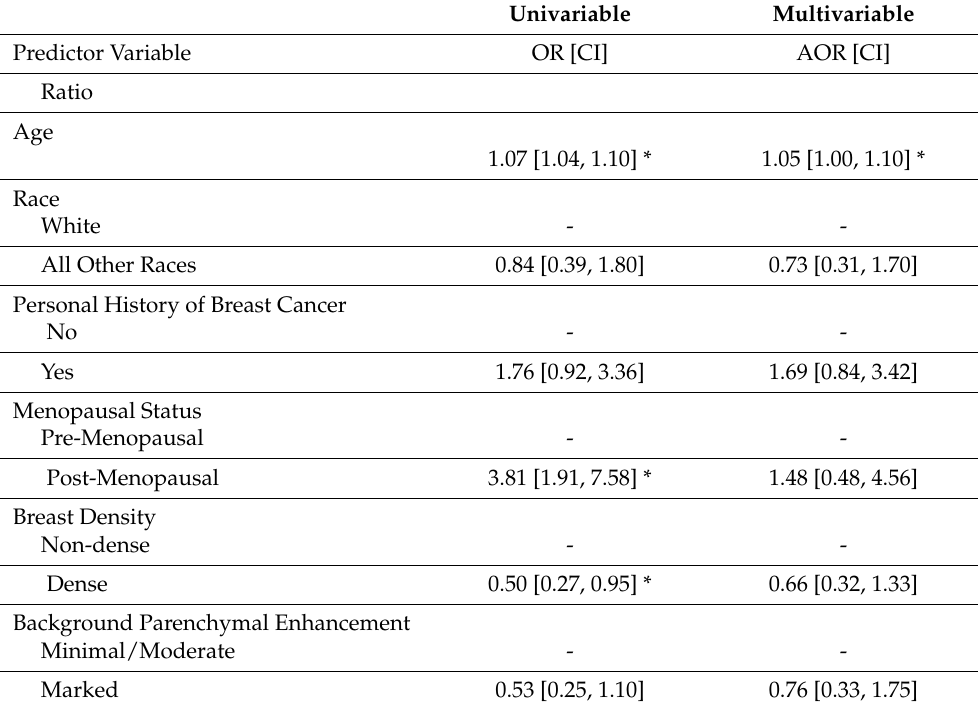
Table 3. Association between predictor variables and malignancy. OR: odds ratio; AOR: adjusted odds ratio; All Other Races includes Black, Asian or Pacific Islander, Other Race, or Race Not Recorded; * statistically significant ( p ≤ 0.05). The numbers in brackets are the 95% CI.